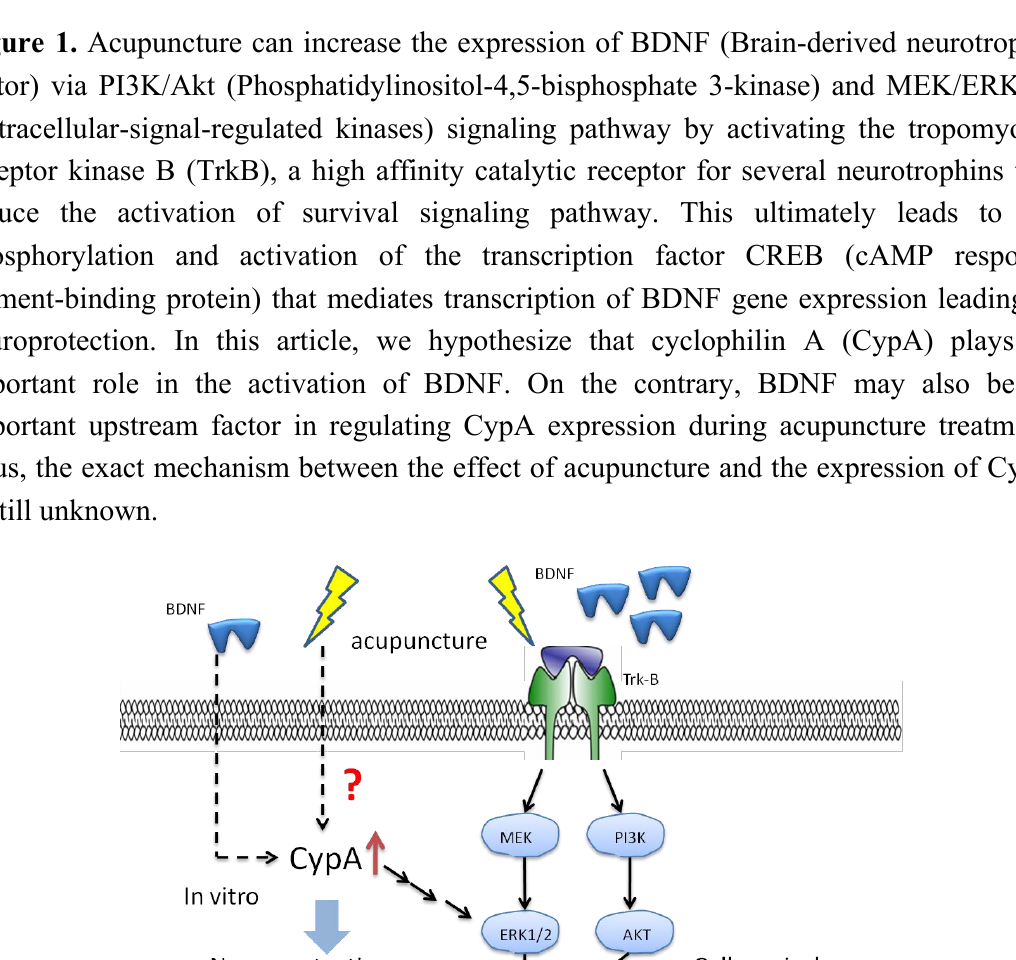
Figure 1. Acupuncture can increase the expression of BDNF (Brain-derived neurotrophic factor) via PI3K/Akt (Phosphatidylinositol-4,5-bisphosphate 3-kinase) and MEK/ERK1/2 receptor kinase B (TrkB), a high affinity catalytic receptor for several neurotrophins